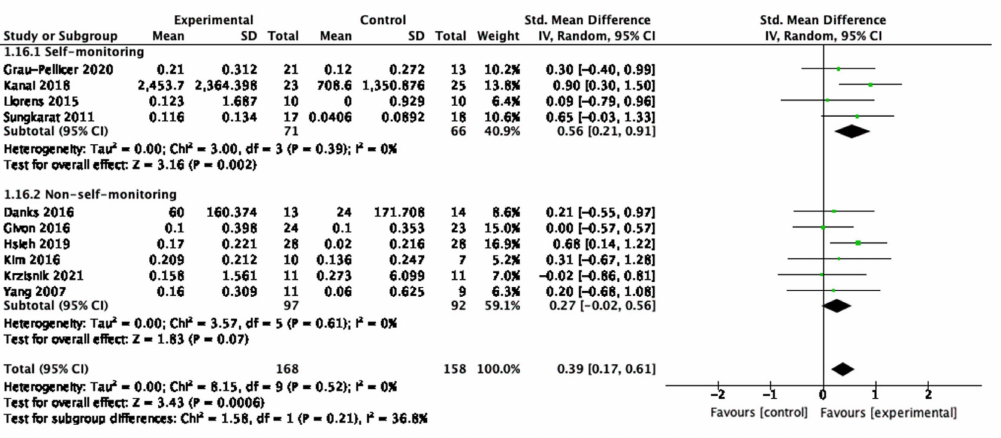
Figure 13. Subgroup analysis for self-monitoring of digital interventions that measured physical activity